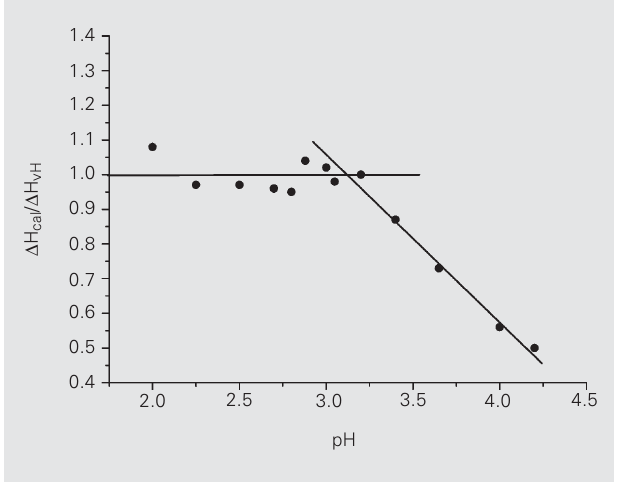
Figure 3. ∆ H cal / ∆ H vH values for ß-trypsin in the acid pH range. Buffers: 50.0 mM ß-alanine with 20.0 mM CaCl 2, except at pH 4.00 and 4.20 where 50.0 mM acetate with 20.0 mM CaCl 2 buffers were used. ß- Trypsin concentration was 1.0